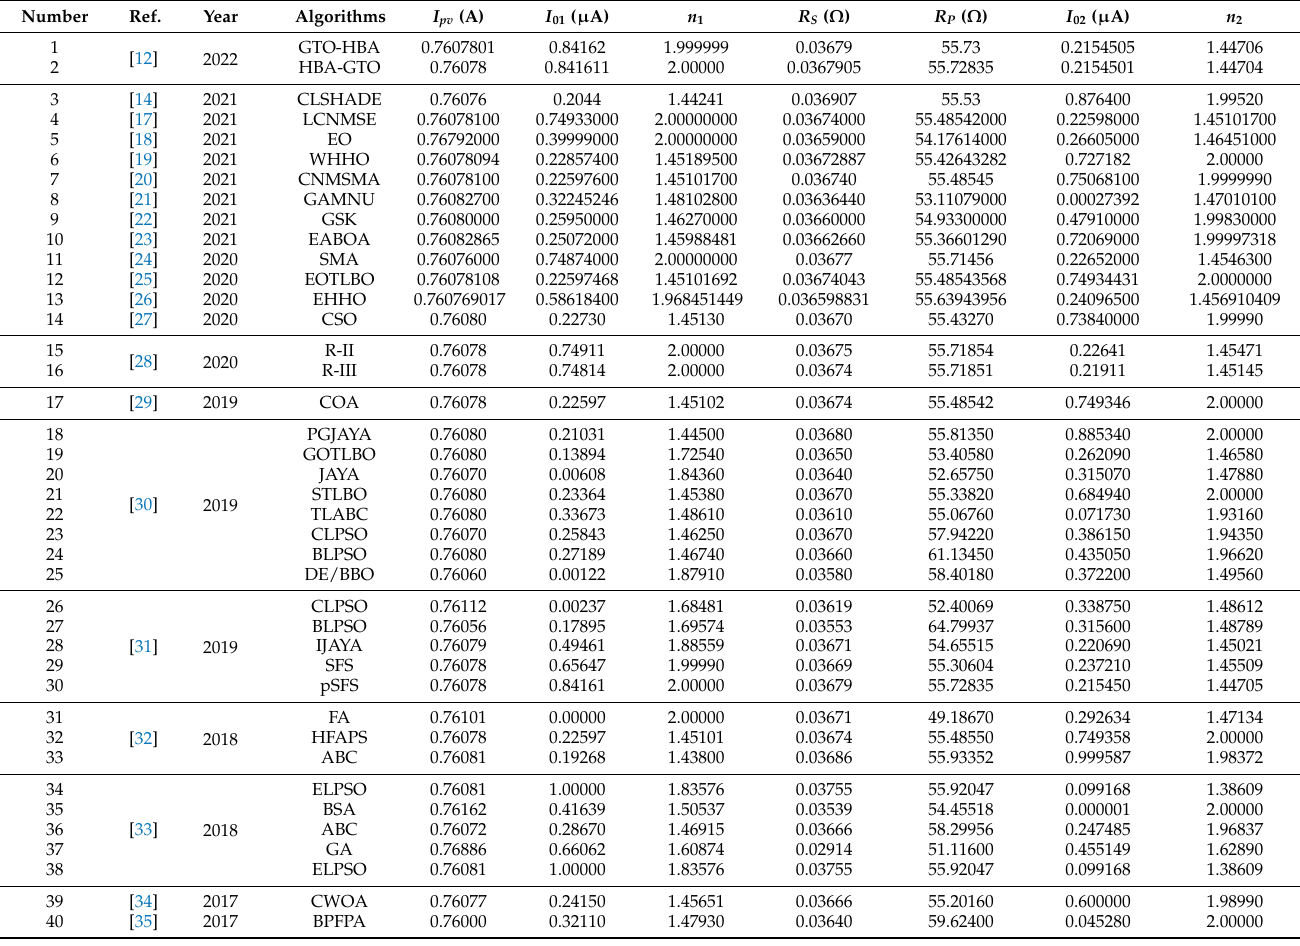
Table 1. DDM parameters for RTC France cell.